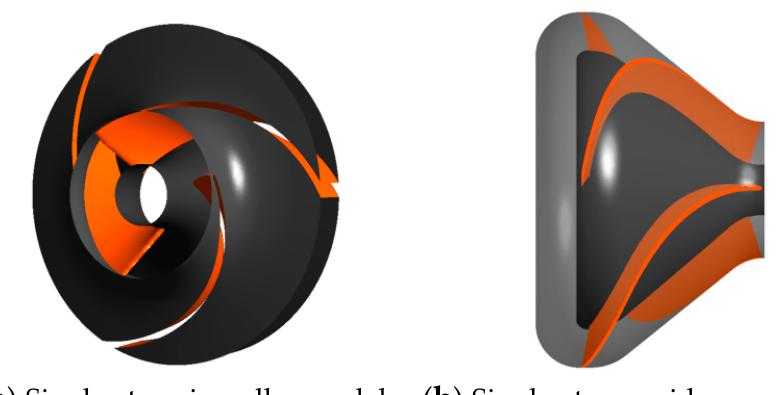
Figure 5. Single-stage impeller and guide vane model.